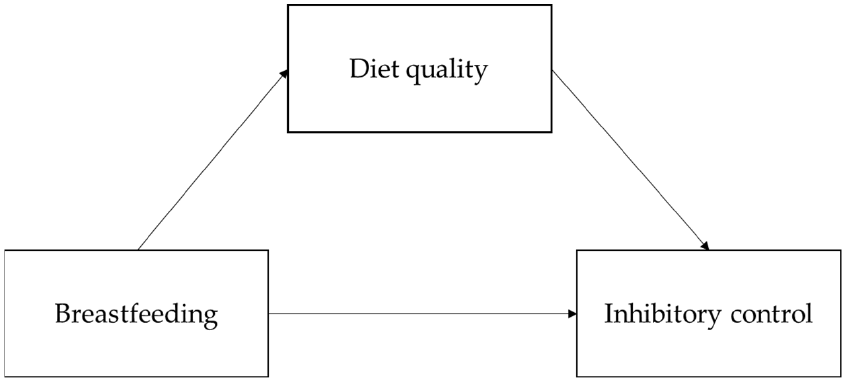
Figure 2. General path diagram of the SEM models.